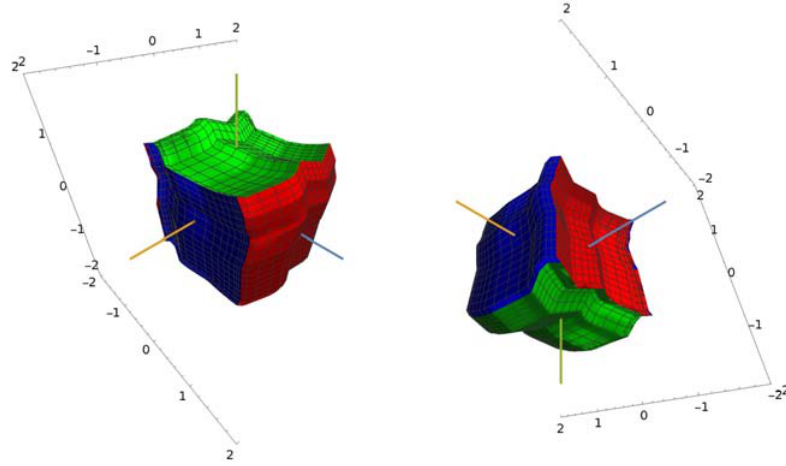
Figure A3: Image of the three - dimensional Fiedler - carpet, in two di ff erent viewpoints, of the graph in Figure